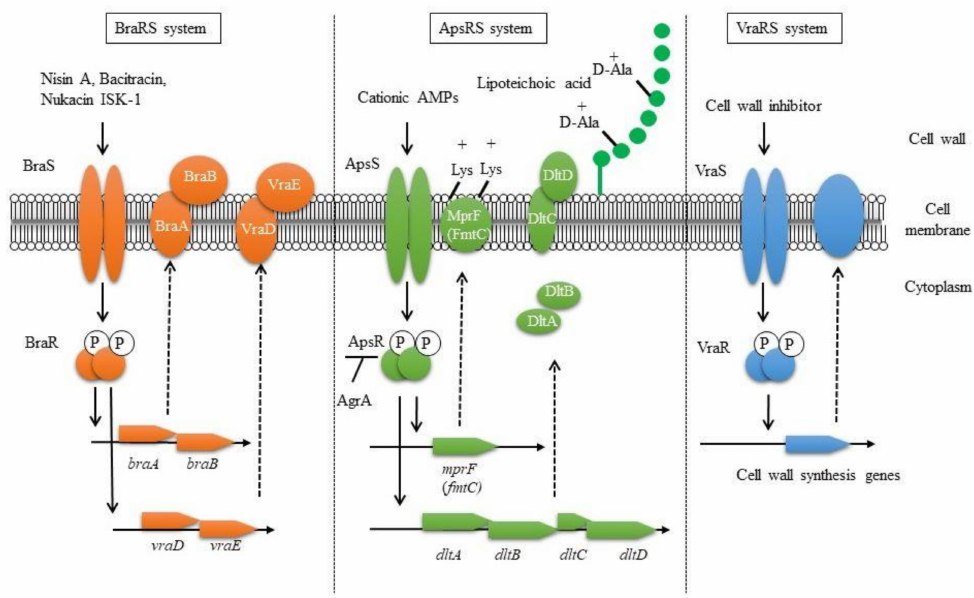
Figure 1. Proposed bacteriocin resistance mechanism mediated by TCSs in S. aureus